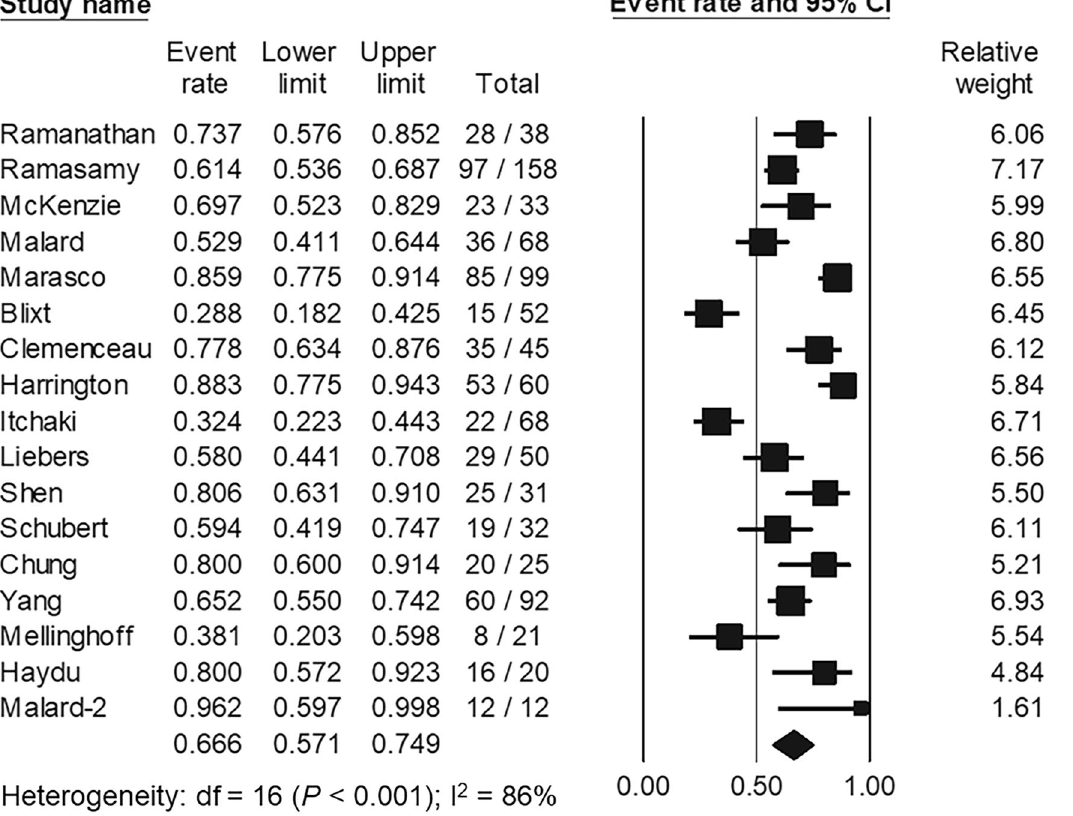
Fig. 5 The pooled proportion of the speci fi c SARS-CoV-2 T-cell response following primary SARS-CoV-2 vaccination in patients with hematologic malignancies. The pooled analysis of 17 studies containing 872 patients with hematologic malignancies showed that the pooled proportion of cellular immune responses was 66.6% (95% con fi dence interval [CI], 57.1 –